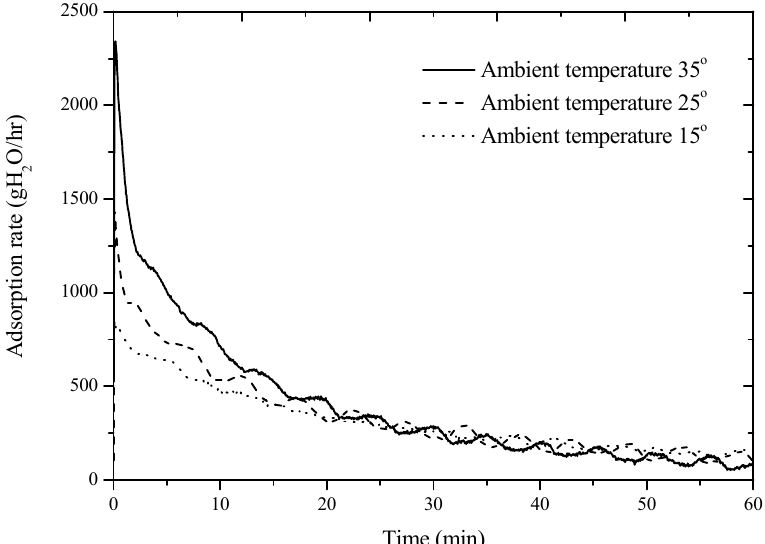
Figure 6. The variation of adsorption rate with time at a relative humidity of air of 85%, at various ambient temperatures with an airflow rate of 90 m 3 /h.